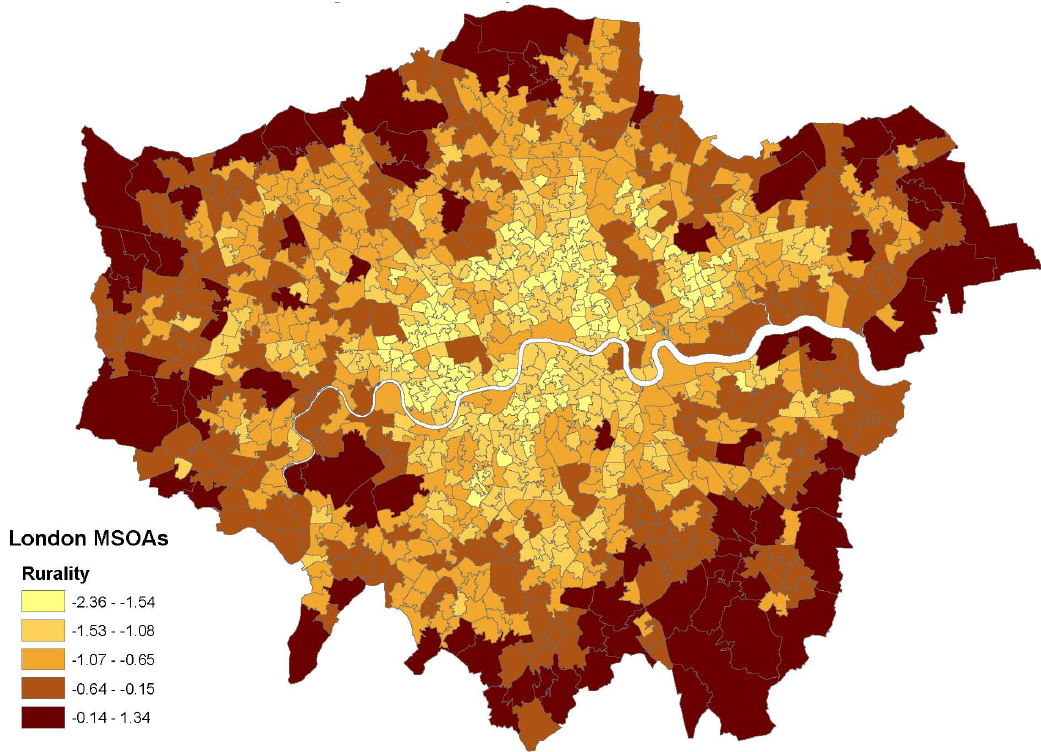
Figure 1. Rurality scores in